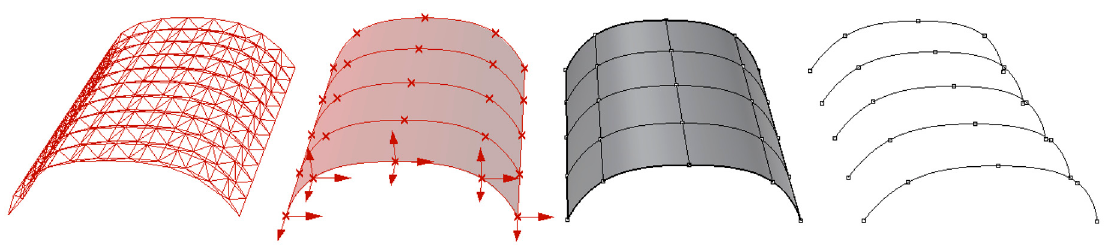
Figure 10. Process of parametric frame structure.